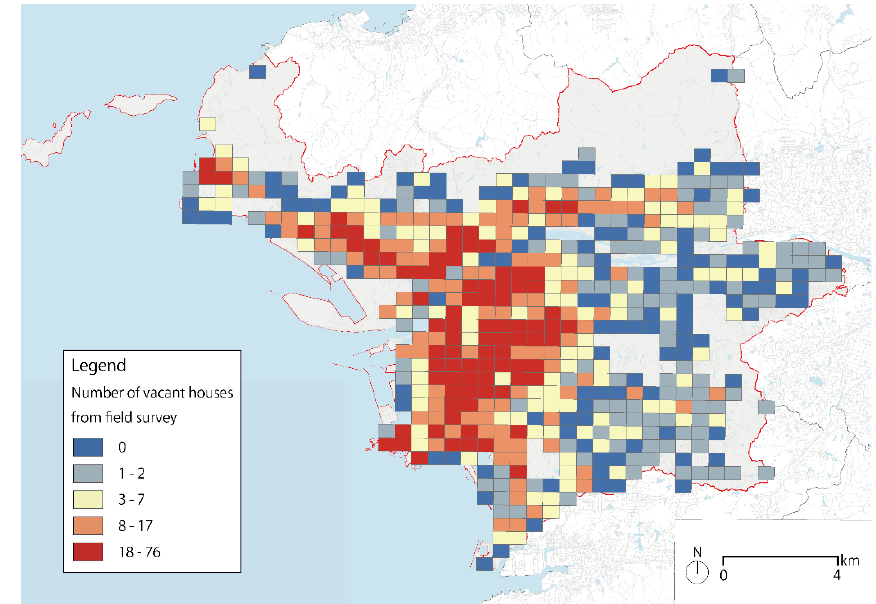
Figure 2. Geographic distribution of vacant houses per 500-meter grid cell